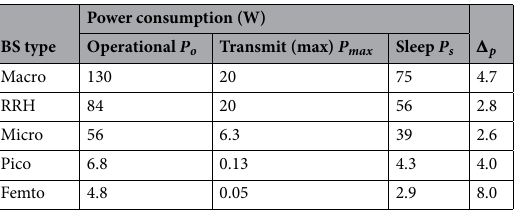
Table 1. Power profiles for each type of BSs 25